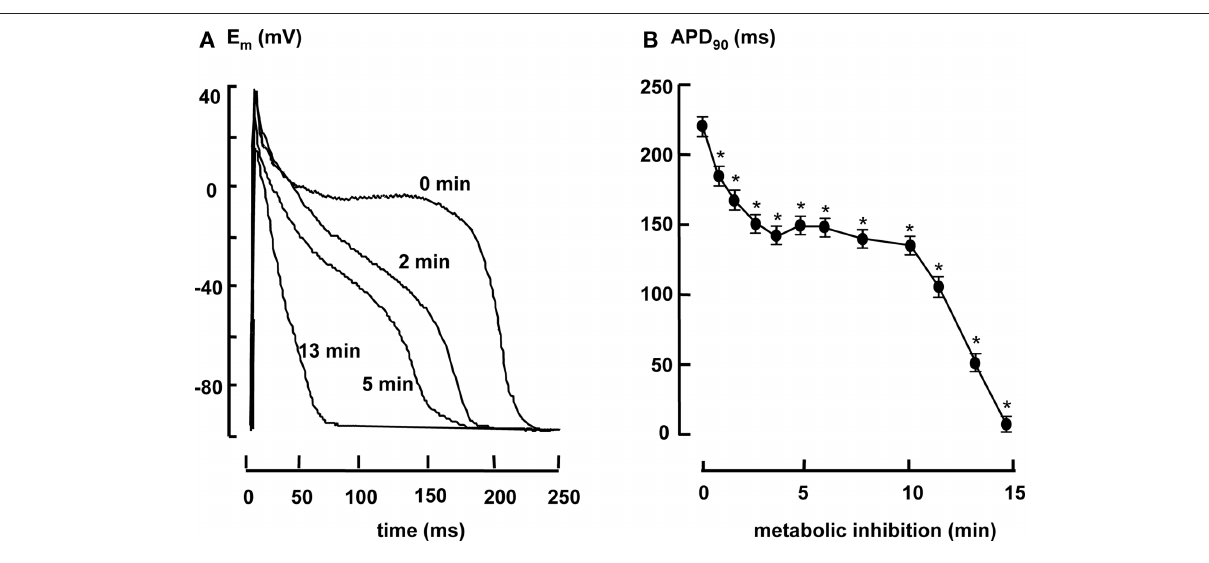
FiguRe 3 | (A) Representative examples of action potentials under aerobic conditions ( t = 0) and after 2, 5, and 13 min of metabolic inhibition. (B) Action potential duration in 2 Hz stimulated myocytes ( n = 20) measured at 90% repolarization (APD versus Ctrl ( t = 0; one way